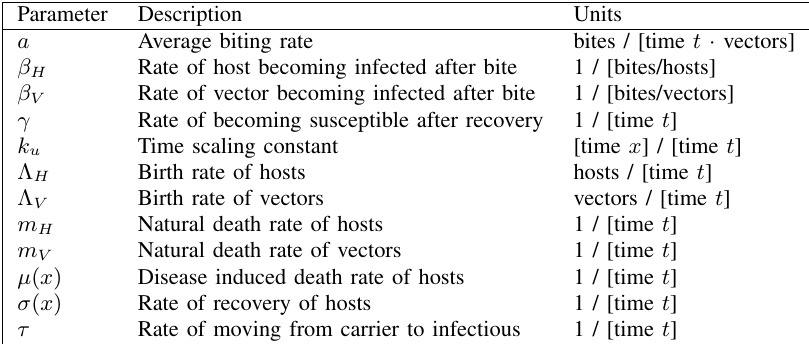
TABLE III: Parameters for the between-host